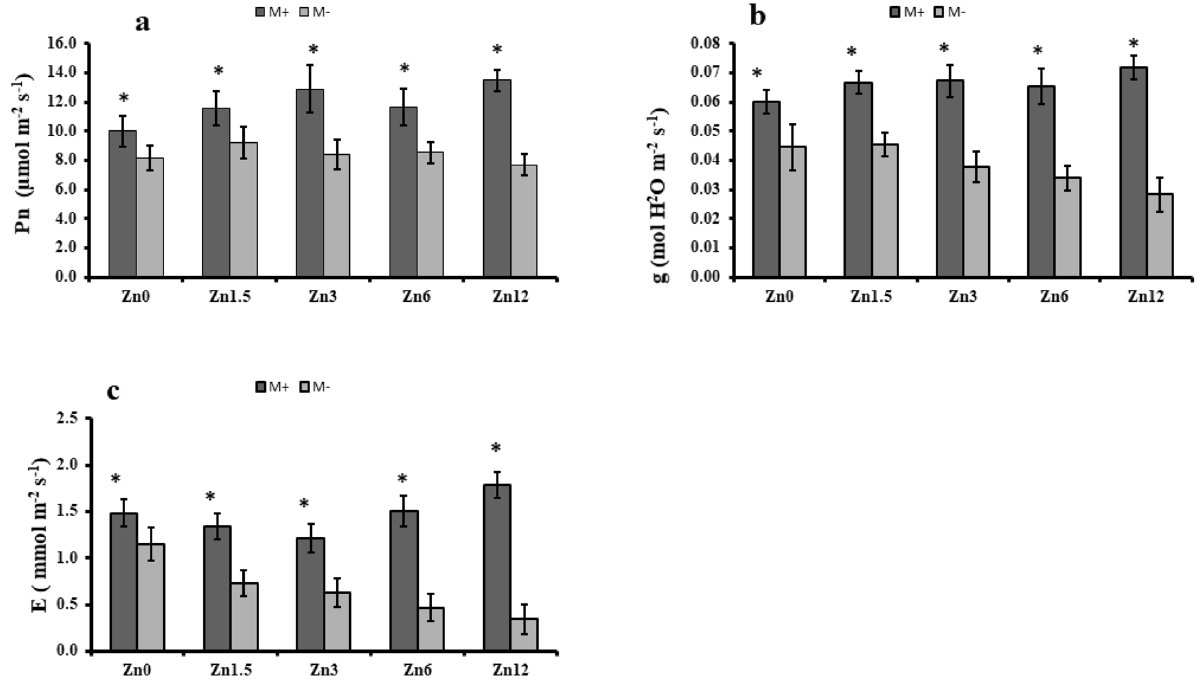
Figure 2. Effect of arbuscular mycorrhizal inoculation on gaseous exchange traits of maize under zinc deficient soil conditions. ( a ) Photosynthetic rate (µmol m -2 s -1 ) ( b ) stomatal conductance (mol H 2 O m -2 s -1 ) ( c ) transpiration rate (mmol m -2 s -1 ). Zn 0 (control), Zn 1.5 (1.5 mg kg -1 ), Zn 3 (3 mg kg -1 ), Zn 6 (6 mg kg -1 ), Zn 12 (12 mg kg -1 ), inoculated with AMF (M + grey), un-inoculated (M- white). Error bars represent standard error and asterisk (*) shows a significant difference ( p ≤ 0.05) among treatments (Zn × AMF interaction).